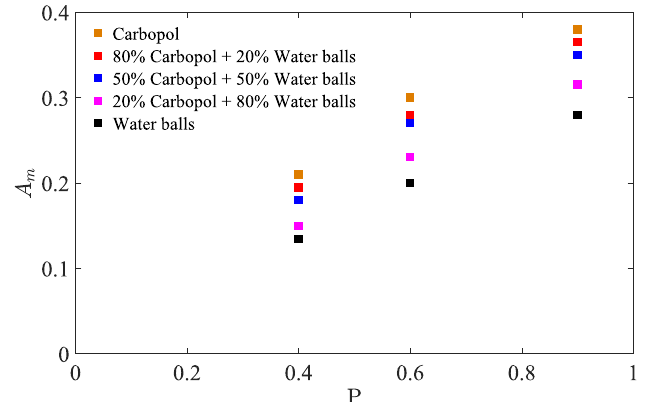
Figure 10. Effects of slide mass material composition on the scaled maximum wave amplitude A m